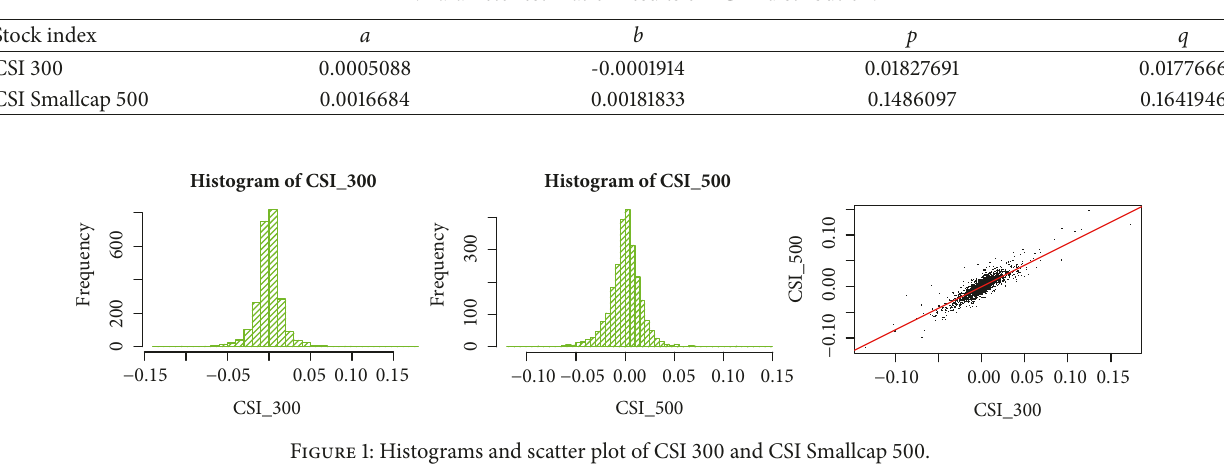
Table 2: Parameter estimation results of EGB2 distribution.